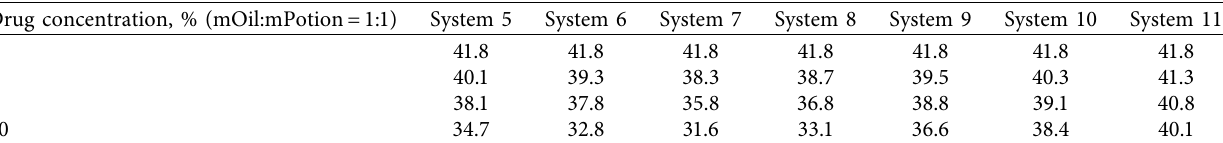
Table 4: Effect of viscosity reducing and wax inhibiting compound on freezing point.